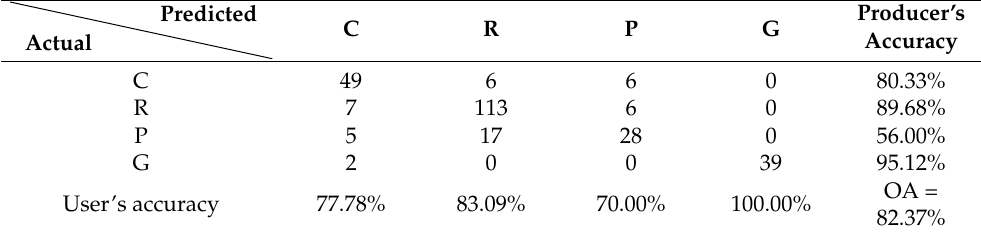
Table 4. Confusion matrix of test